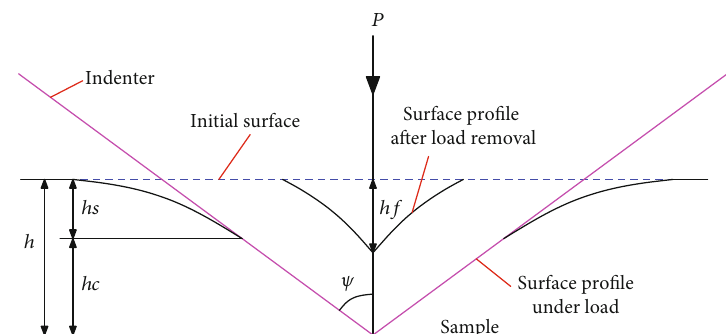
Figure 2: Schematic diagram of loading and unloading process [17].